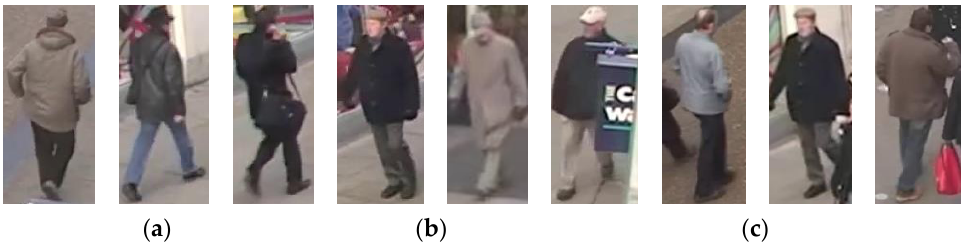
Figure 5. Examples of false-negative retrieval: ( a ) Query1, ( b ) Query7, ( c ) Query8.